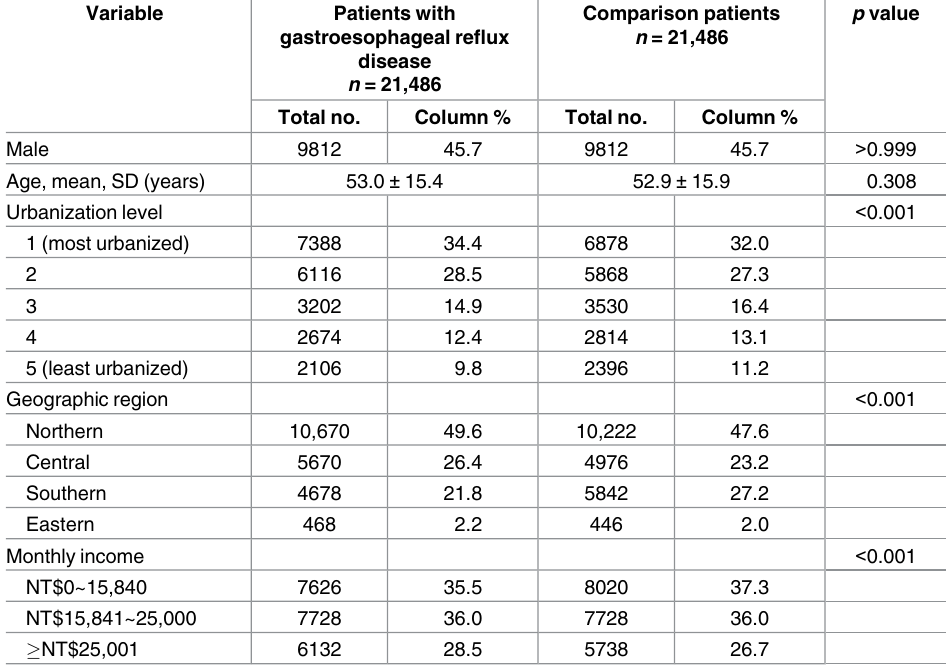
Table 1. Demographic characteristics of sample patients (N =